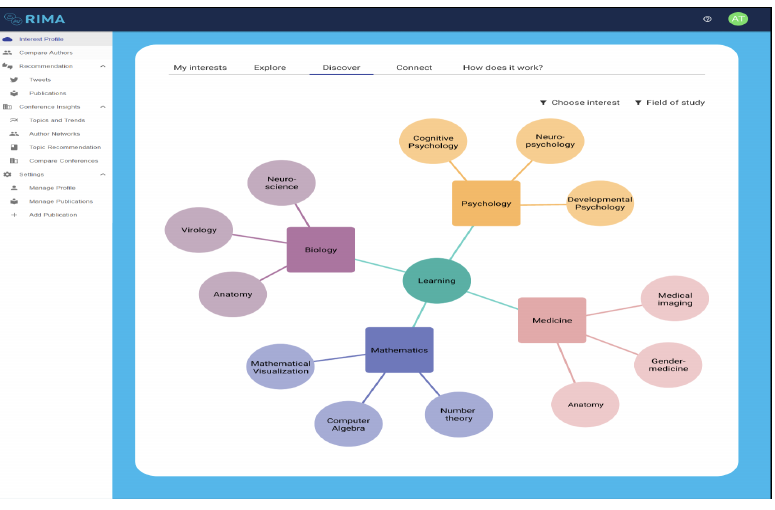
Figure 20. Discover new